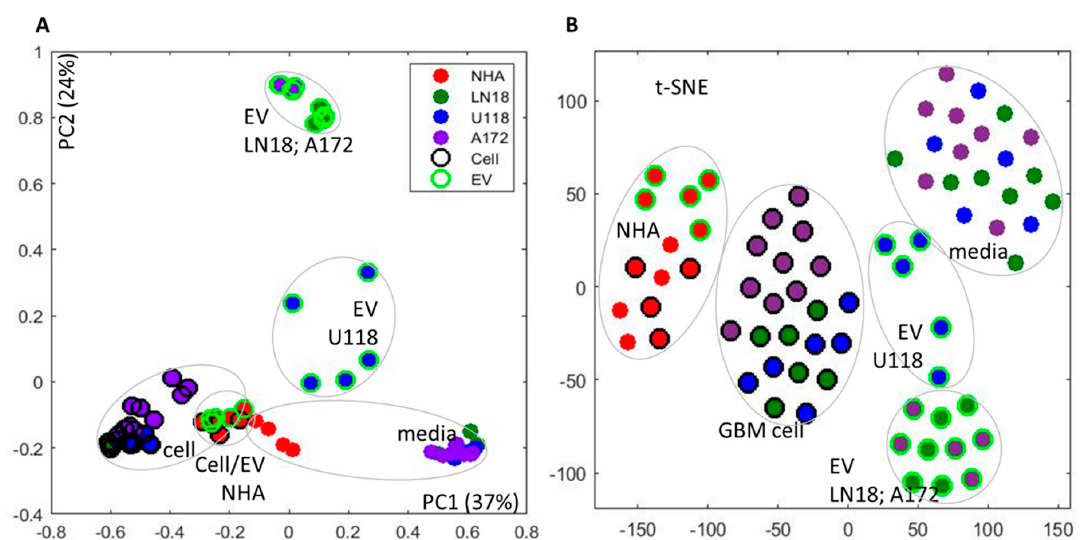
Figure 2. Analysis of sample differences from 1D Nuclear Overhauser Effect Spectroscopy (NOESY 1D) 1 H NMR spectra of cells, media and EVs for glioblastoma (GBM) cell lines (LN18, A172 and U118) and normal human astrocytes (NHA). ( A ) Principal component analysis (PCA); ( B ) t-distributed stochastic neighbor embedding (t-SNE). Grouping of sample source (cells, EV, media) as well as cell type is indicated.